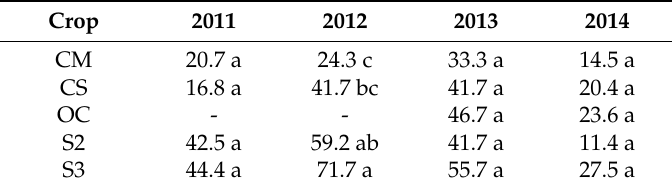
Table 3. Mean weed cover (%) in the different crops. CM: cereal monocrop, CS: cereal after